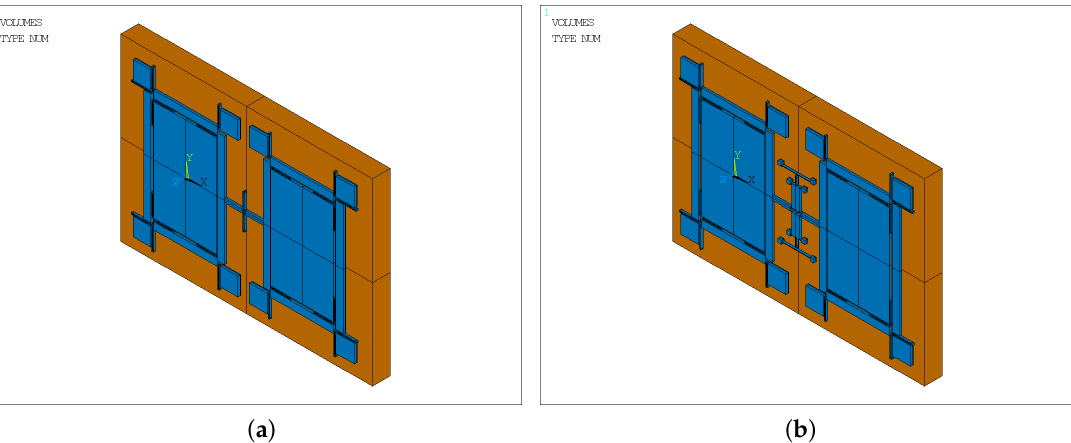
Figure 15. Simulation models of the two types of gyroscopes: ( a ) the Type-A structure; ( b ) the Type-B structure.